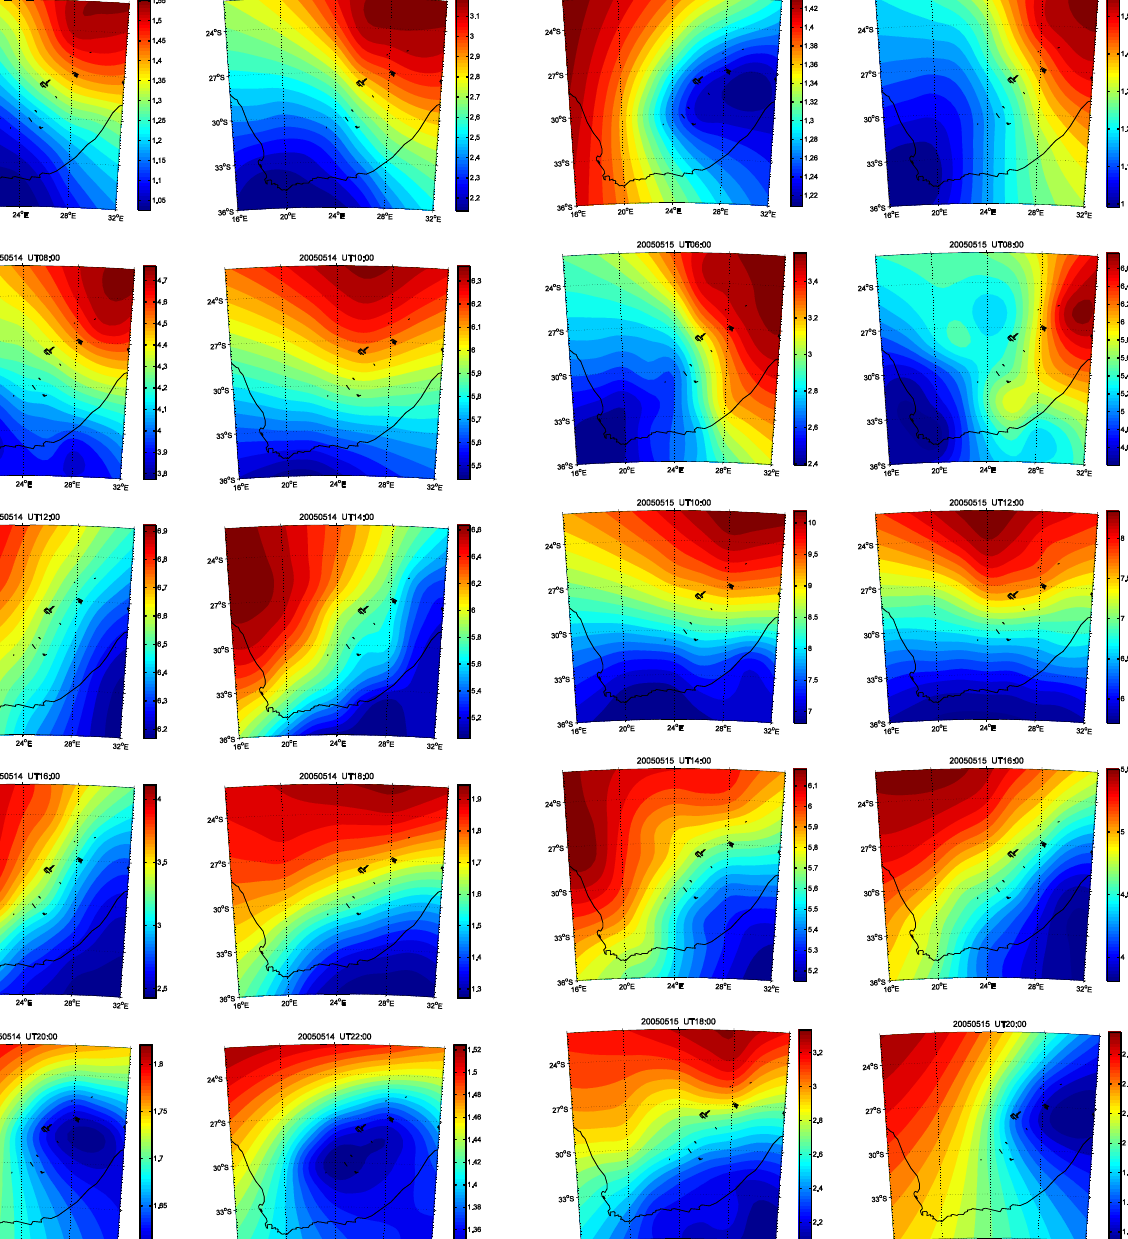
Figure 4 Map of the electron density changes at an altitude of 350 km from 04:00UT on 14 May to 20:00UT on 15 May(unit: 10 11 el/m 3